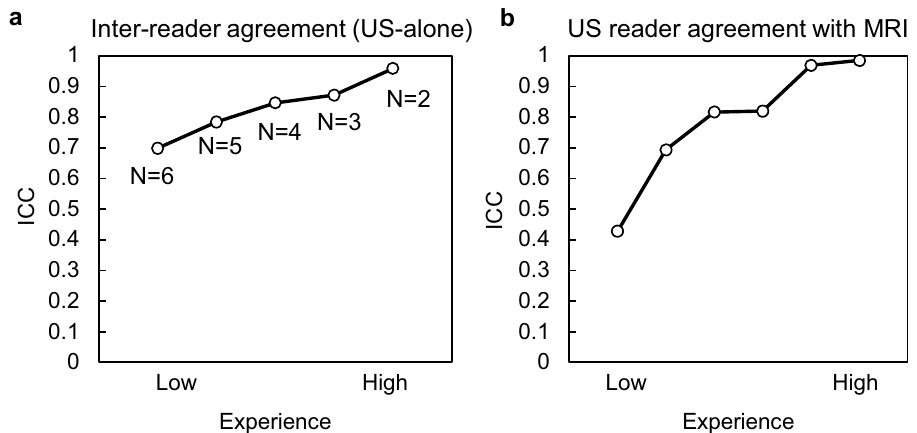
Figure 6. Inter-reader variability and accuracy. ( a ) Plot showing ICC values between US measurements for various groupings of readers based on experience levels. ( b ) ICC values between each individual reader’s US measurements and MRI ordered by experience. ICC –intra-class correlation